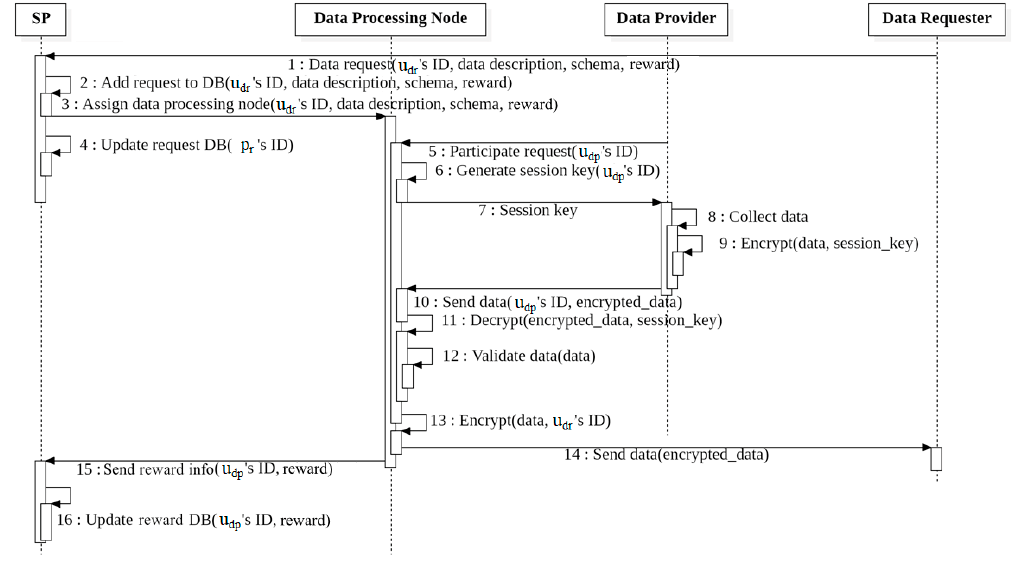
Figure 8. Sequence diagram of proposed system.